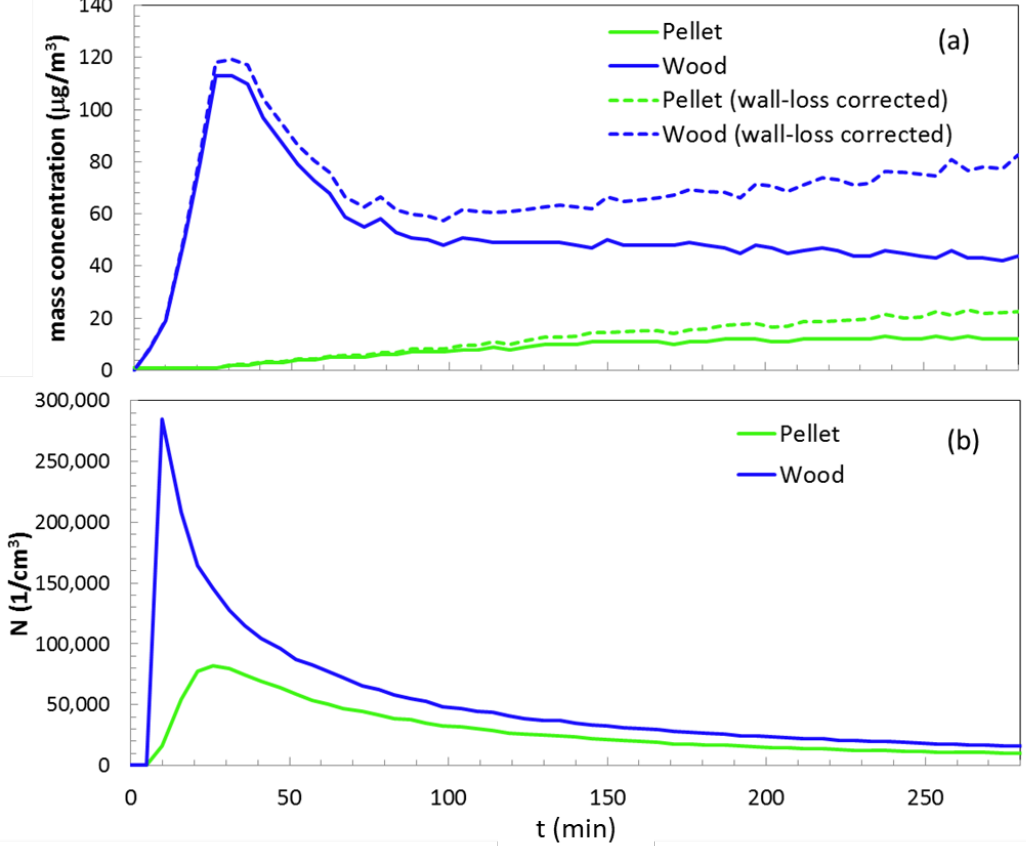
Figure 3. Mass ( a ) and number ( b ) of secondary particles during UV irradiation of pellet and wood combustion emissions, respectively.